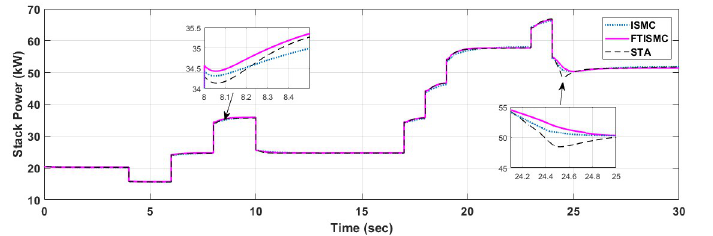
Fig 8. Stack power produced by PEM fuel cell.